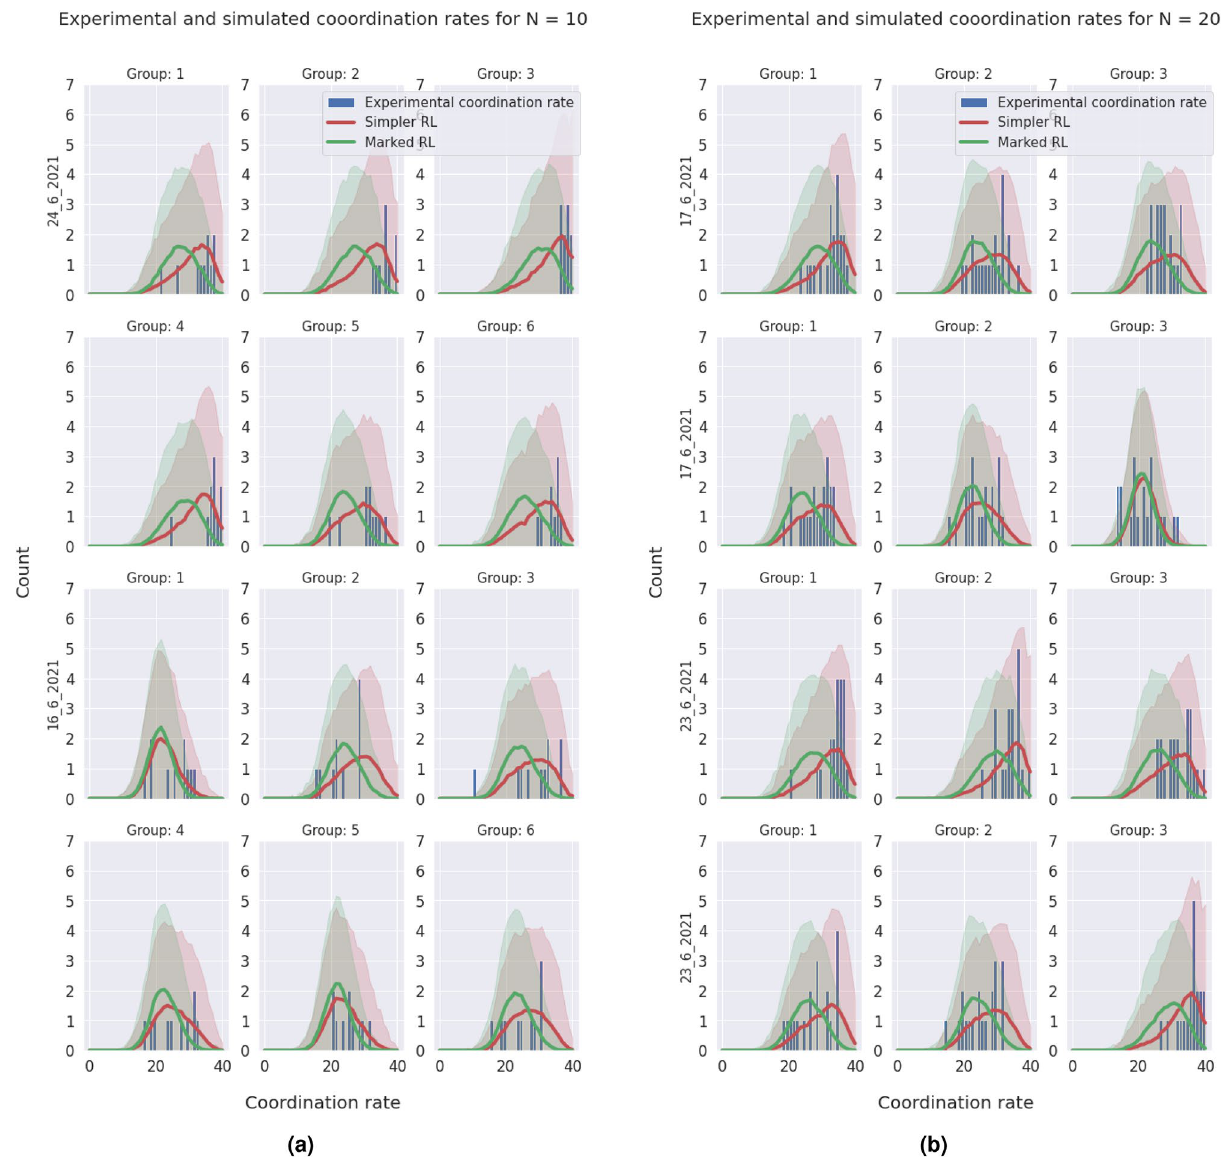
Figure 7. ( a ) Coordination rate distribution for the different populations with N = 10 for the rounds (0, 40). ( b ) Coordination rate distribution for the different populations with N = 20 for the rounds (0,